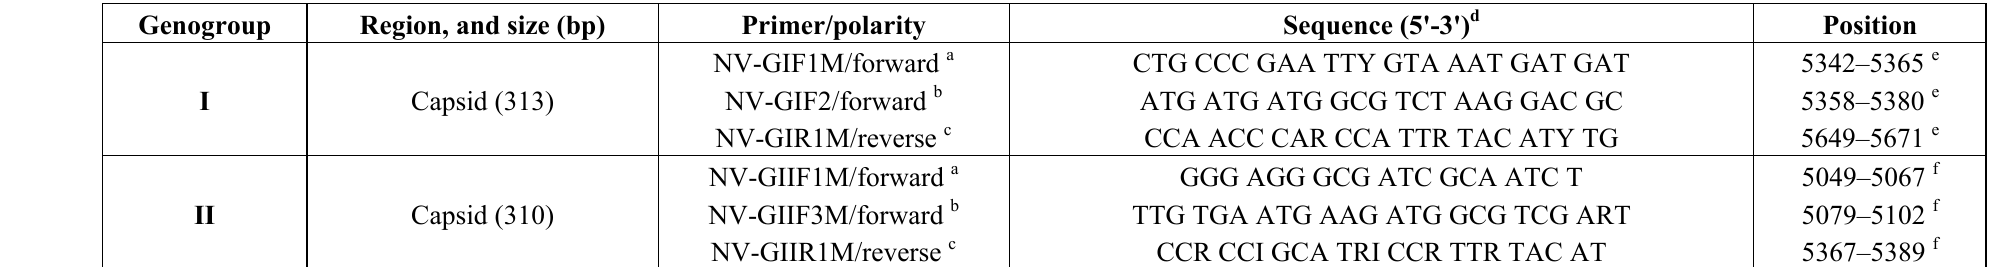
Table 1. Primers used for nested RT-PCR assays.